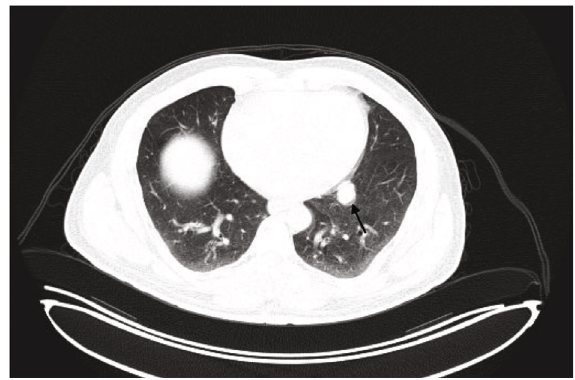
Figure 4: High-resolution chest CT showing another left lower lung lobe paracardiac lung mass denoting another metastatic